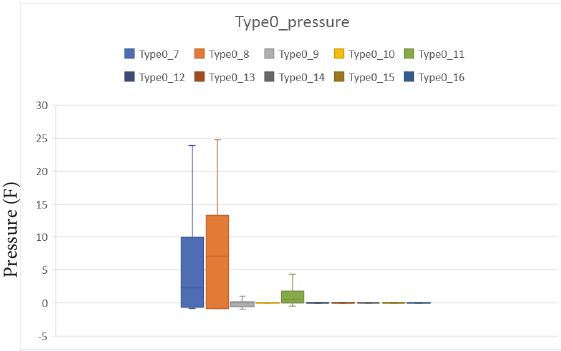
Figure 7: Vision pressure of car-following (the numbers in the legend refer to Table 3).